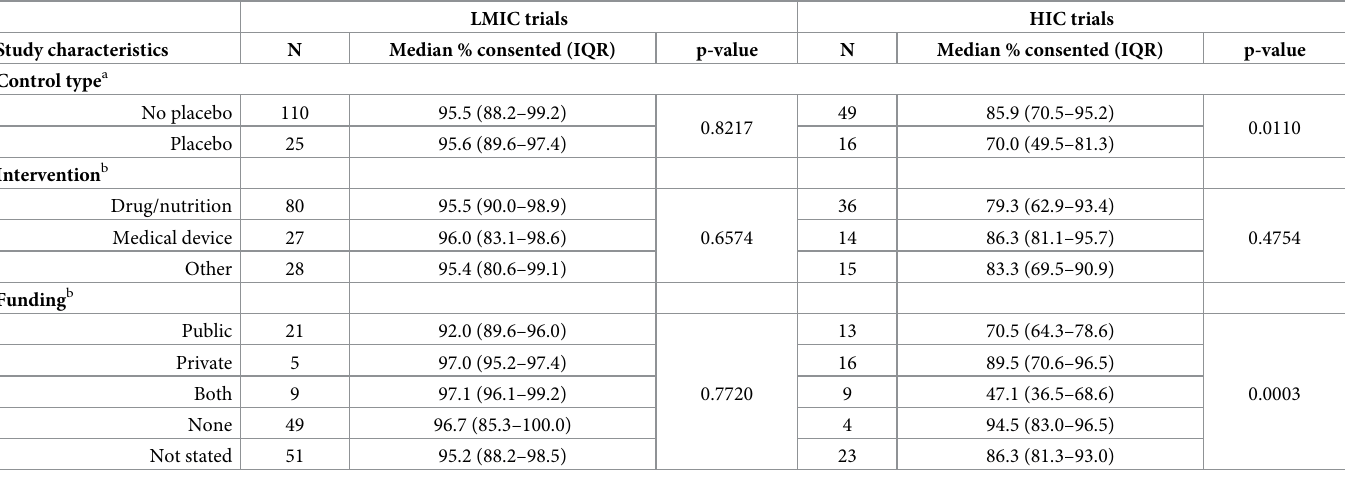
Table 3. Effect of study characteristics on consent rates within LMIC and HIC trials.